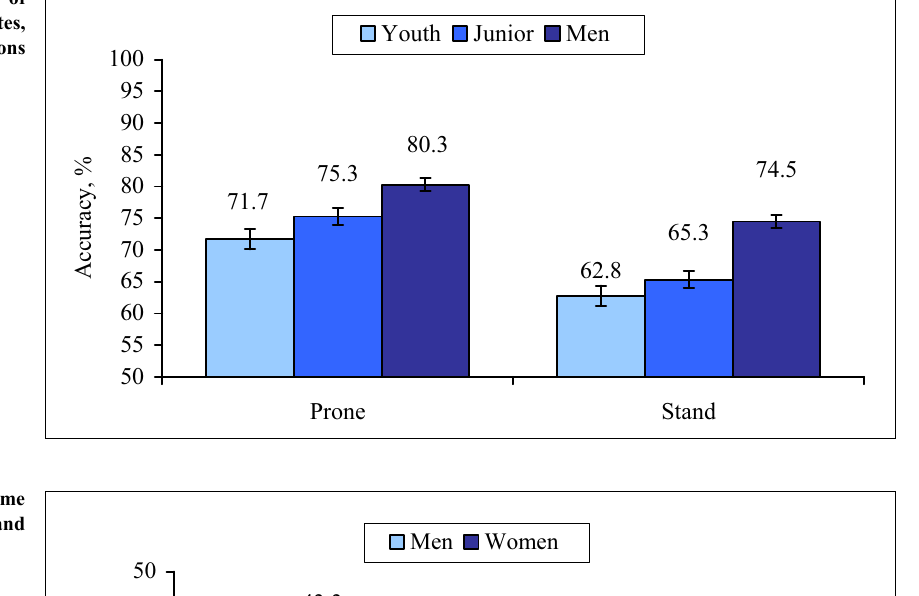
Figure 2. Shooting accuracy of various age group men biathletes, in prone and stand positions (X ± Sx)